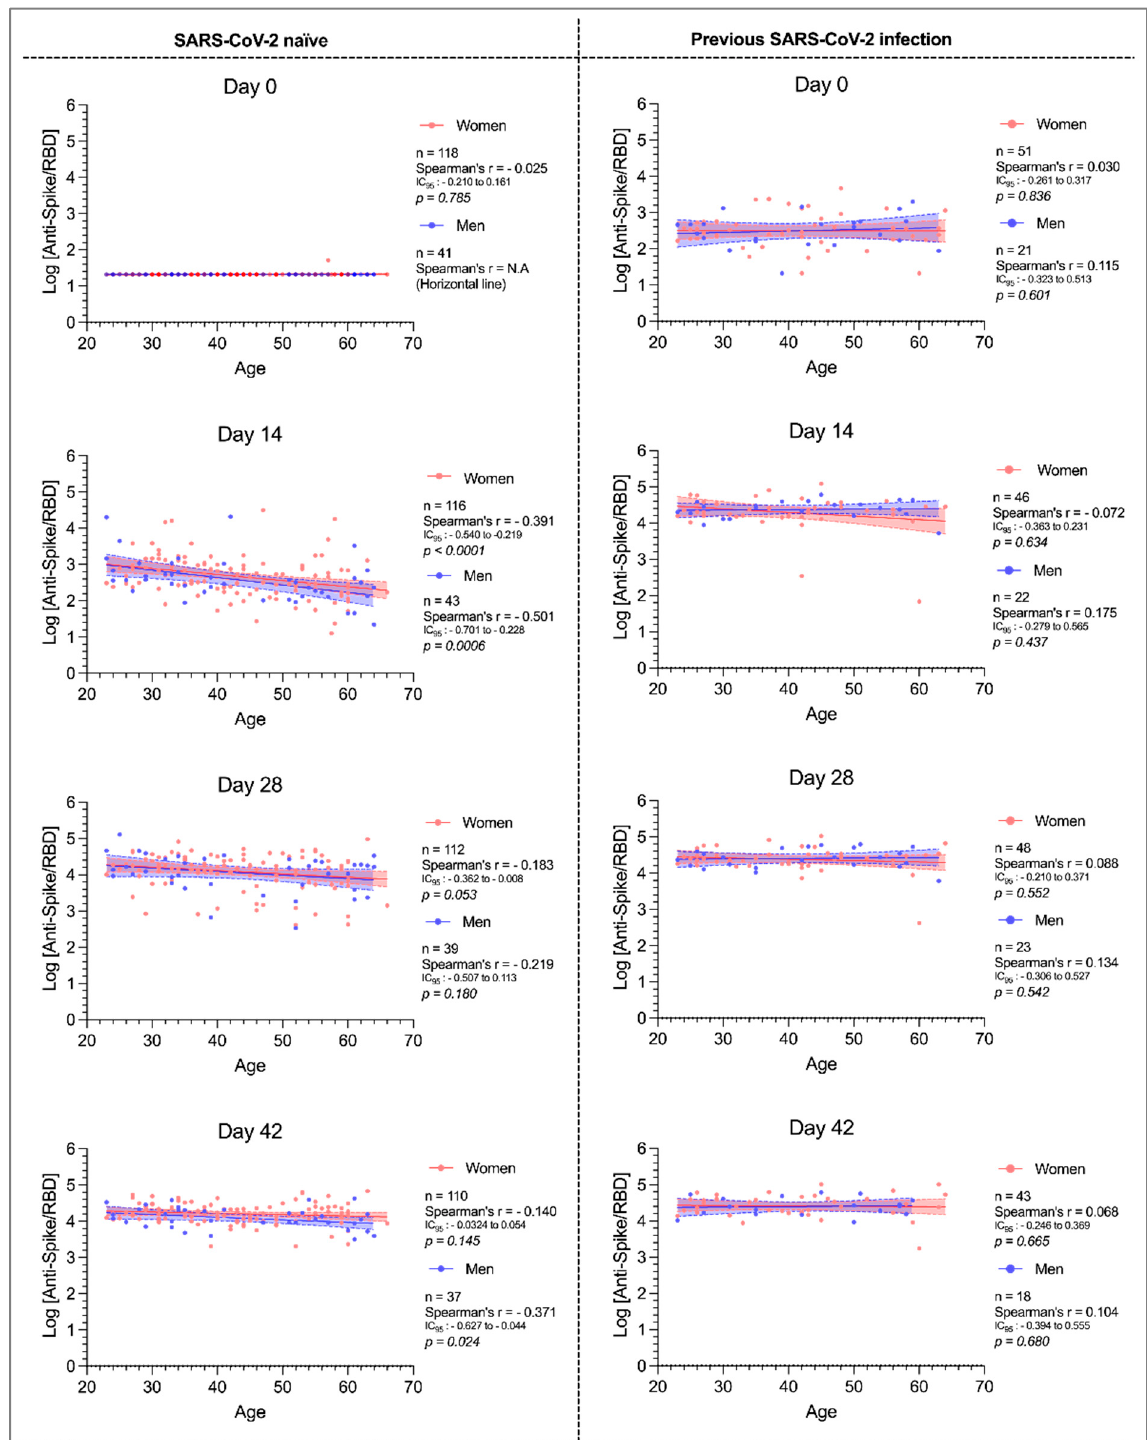
Figure 2. Simple linear regressions, with Spearman’s correlation coefficients, between log 10 -transformed anti-Spike/RBD values and age in previous or naïve SARS-CoV-2 infected people. The number of patients at the different timepoint may change due to loss of follow-up.